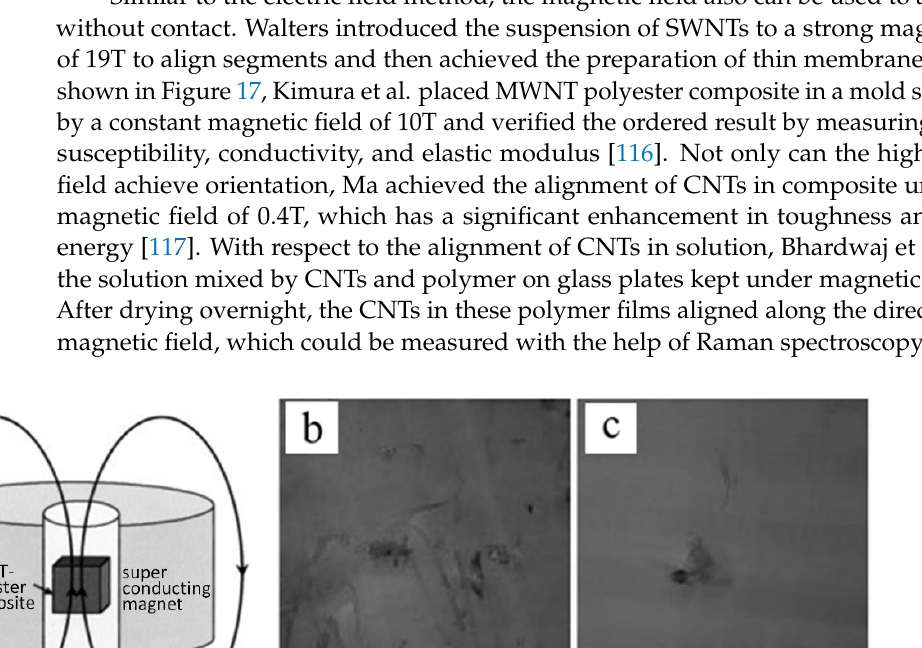
Figure 16. ( a ) Schematic of the collector with two pieces of conductive silicon strips separated by a gap. Reproduced with permission [107]. Copyright 2003, American Chemical Society. AFM images of ( b ) cross-aligned SWNTs/PVP composite fibers and ( c ) cross-aligned SWNT array after etching PVP. Reproduced with permission [108]. Copyright 2004, American Chemical Society.